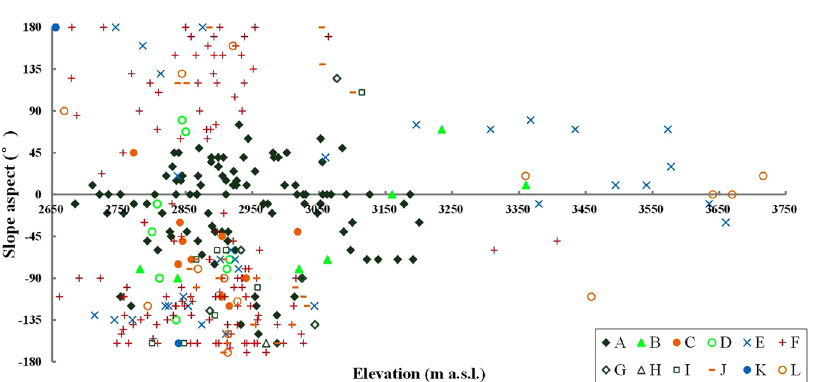
Figure 2. The vegetation distribution with relation to elevation and slope aspect in Pailugou watershed. This map was generated using Microsoft Excel 2010